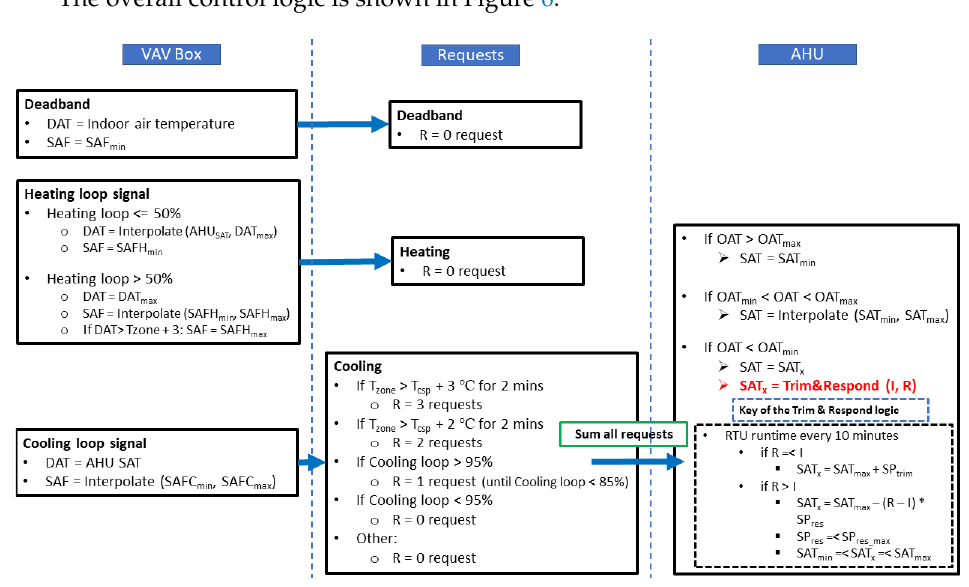
Figure 6. Overall control logic for VAV box and AHU. (DAT: discharge air temperature; SAFH: supply air flow rate for heating; SAFC: supply air flow rate for cooling; R: number of requests; I: ignored responses; SP: respond amount.)